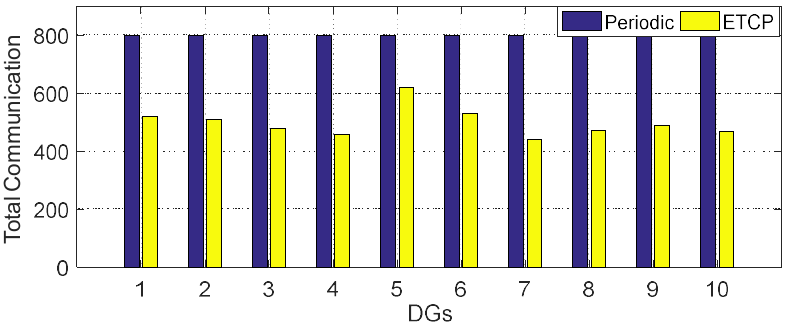
Figure 19. Total communication numbers of ETCP and PC under power generation fluctuation